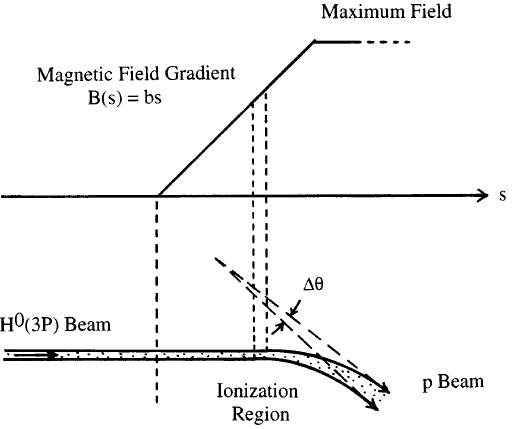
FIG. 5. Stripping of an H (cid:48) (cid:115) (cid:51) (cid:80) (cid:100) pencil beam in a magnetic- field gradient and angular divergence of the resultant proton